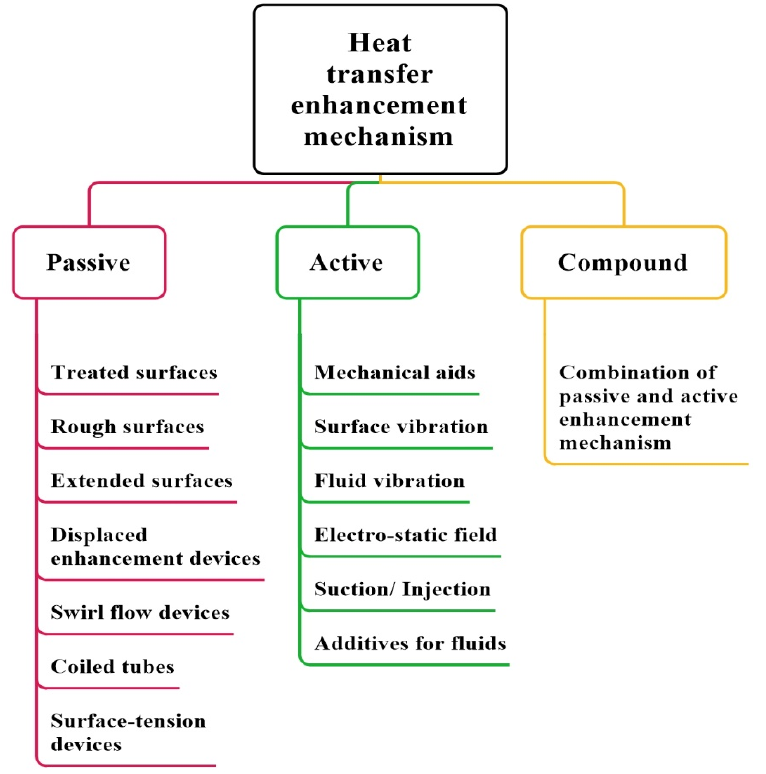
Figure 4. Heat transfer enhancement mechanism.